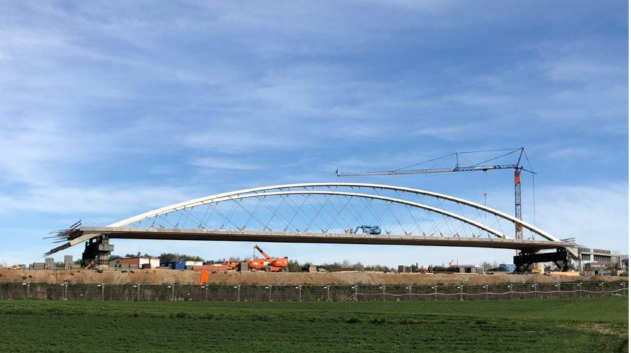
Figure 1. Network arch bridge with inclined CFRP cables, reprinted from ref. [9], reproduced with permission by Prof. Urs